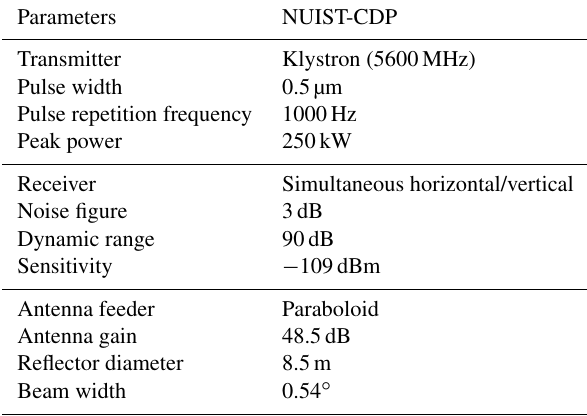
Table 1. Main parameters of